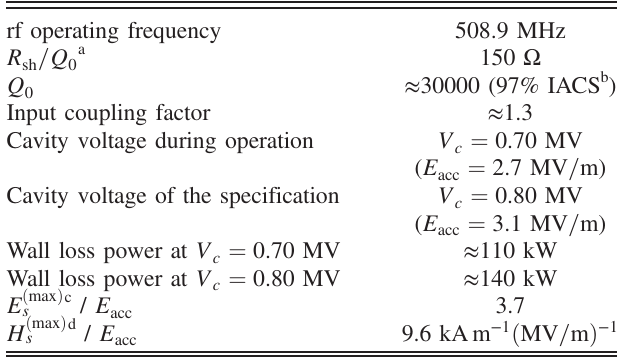
TABLE I. Design parameters of the DR